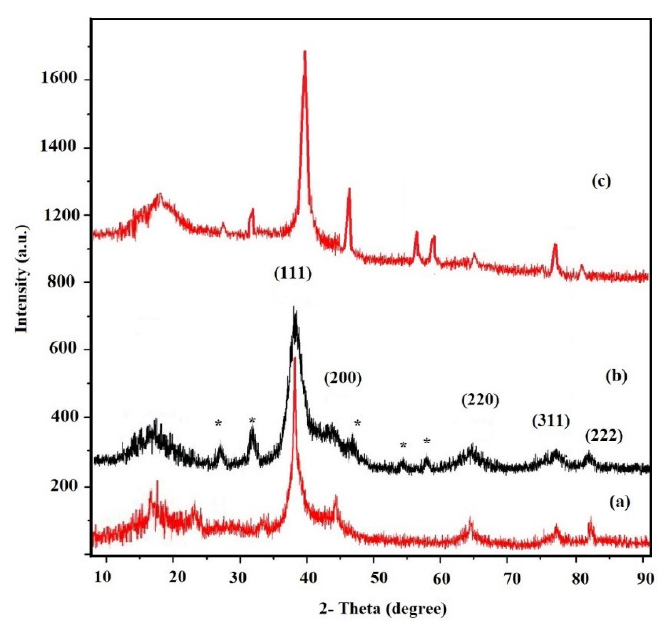
Figure 2. XRD diffractograms of ( a ) ELOA-Ag, ( b ) ELOA-Ag and ( c ) ELNA-Ag NPs.